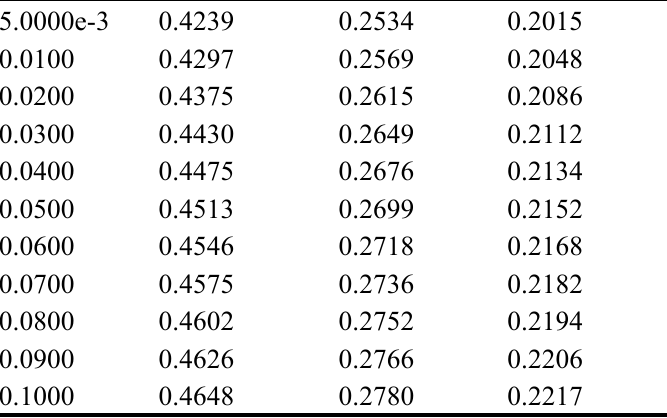
Table 8. Numbers used for plotting Figure 12 for e.m.f. of cell predicted by solving the Born dielectric